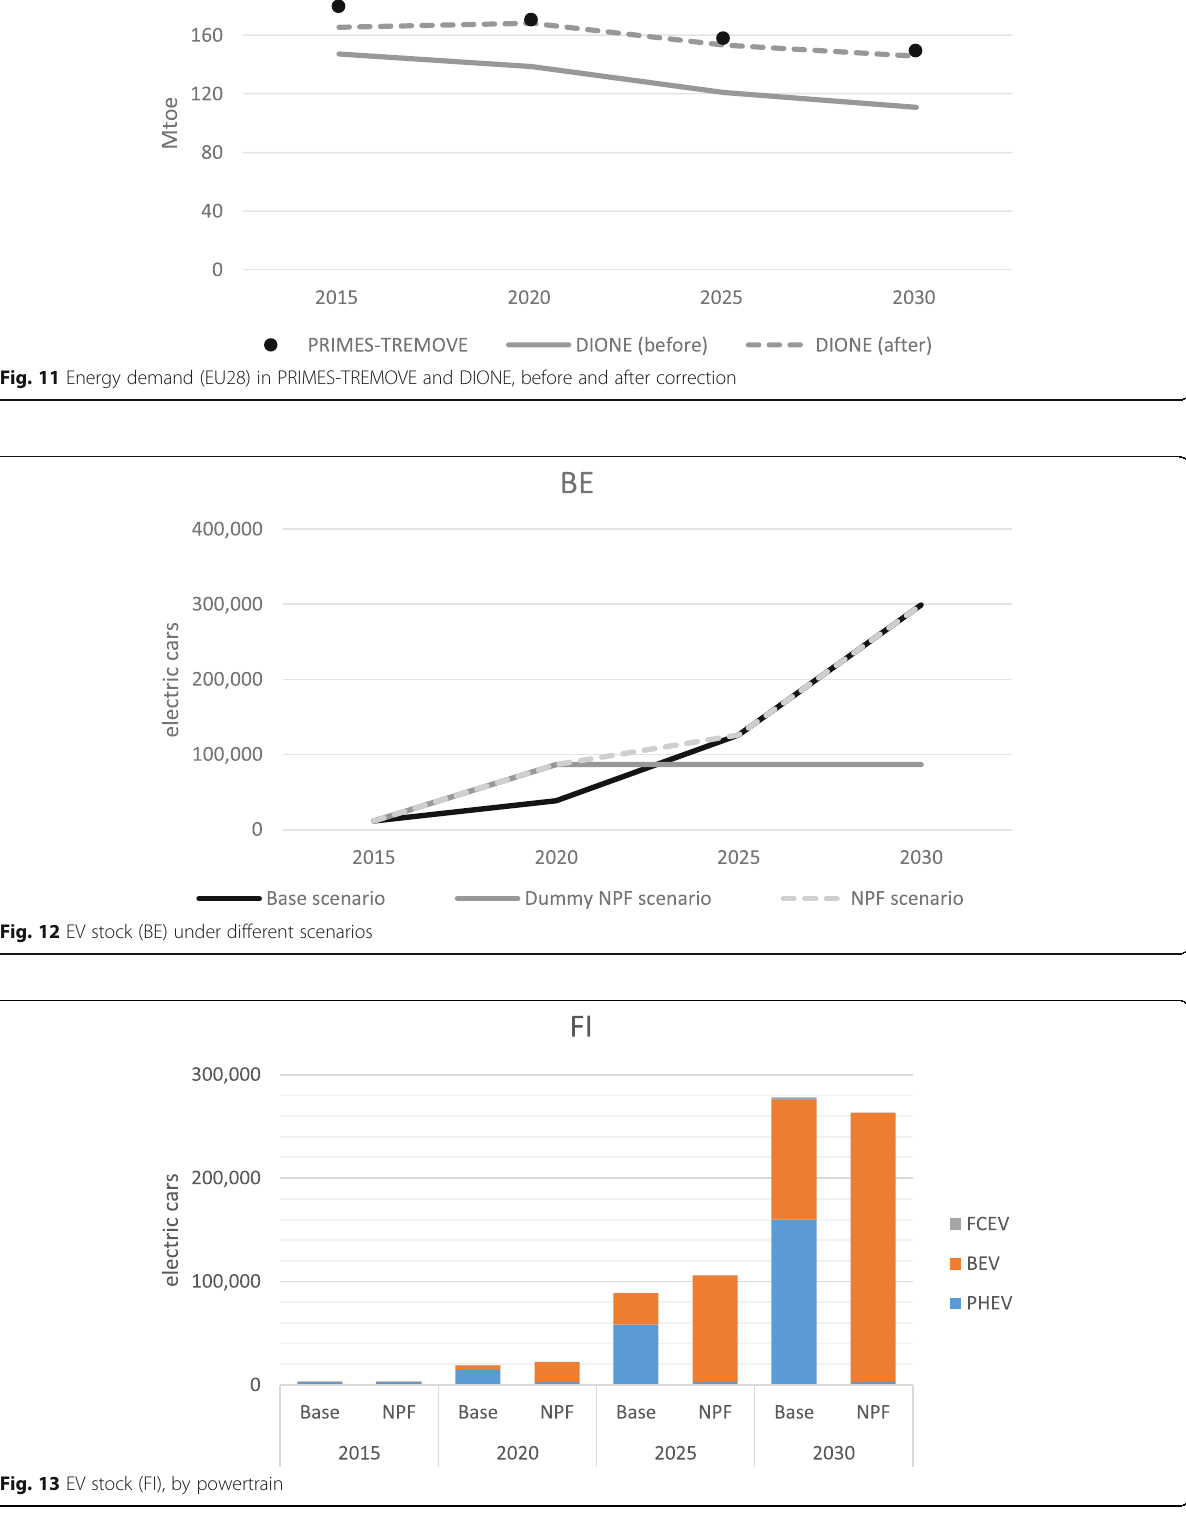
Fig. 13 EV stock (FI), by